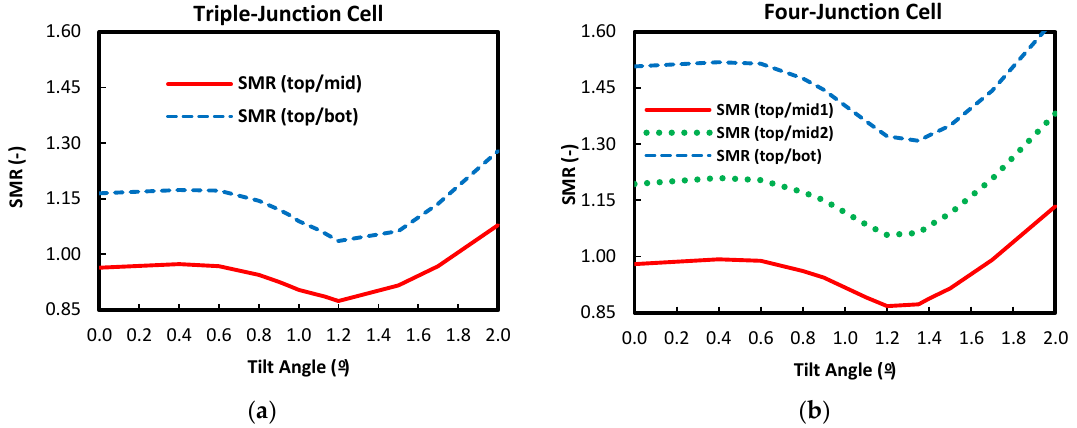
Figure 4. Spectral matching ratio plots of both HCPV units depending on the MJSC applied; ( a ) TJSC [13]; and ( b ) FJSC, as a function of the tilt angle of the incoming light.